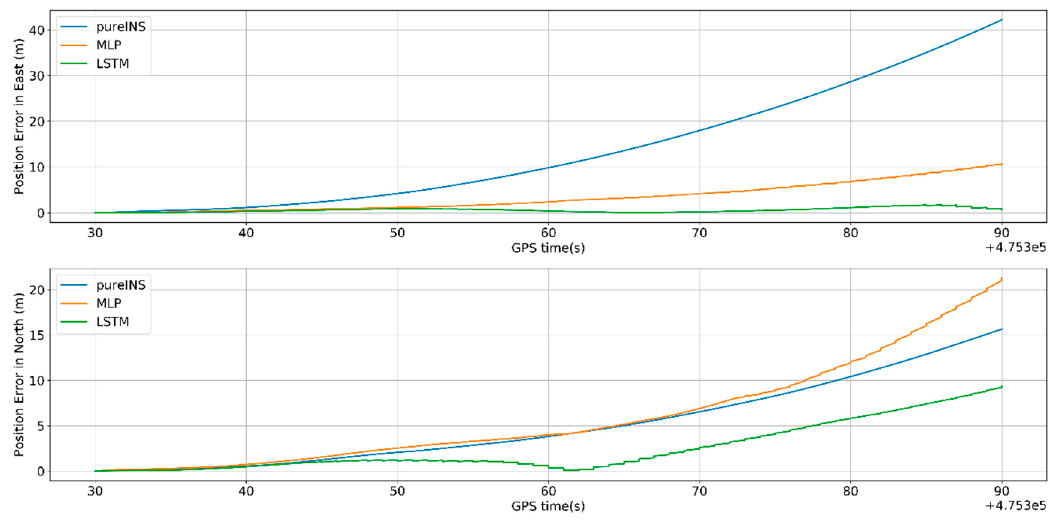
Figure 12. Position errors of 60 s outages with different algorithms.